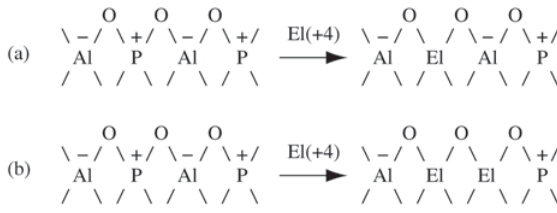
Figure 2. Isomorphous substitution on an AlPO structure: a) [PO 4+ ] by [ElO ] and b) both [PO 4+ ] and [AlO 4- ] by 2[ElO 4